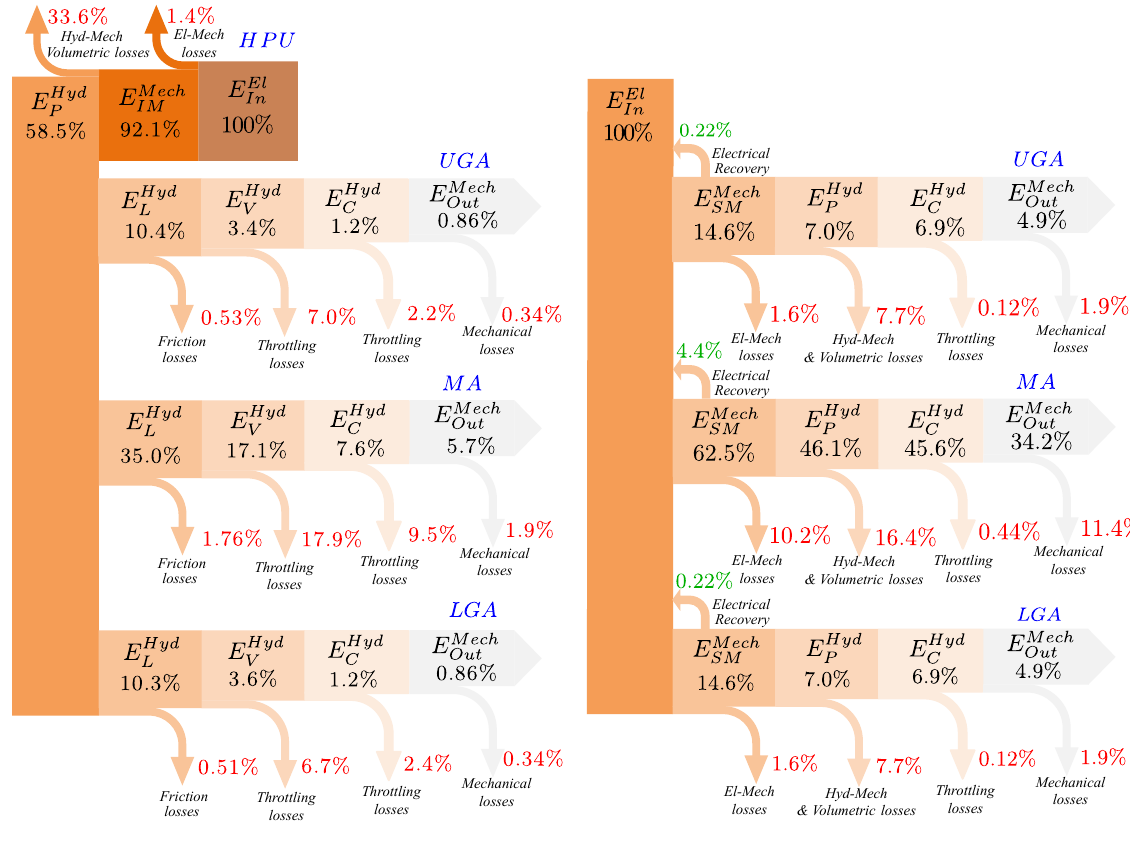
Figure 26: Sankey diagrams showing the energy distribution from electrical input to mechanical output: (left) benchmark system; (right) self-contained